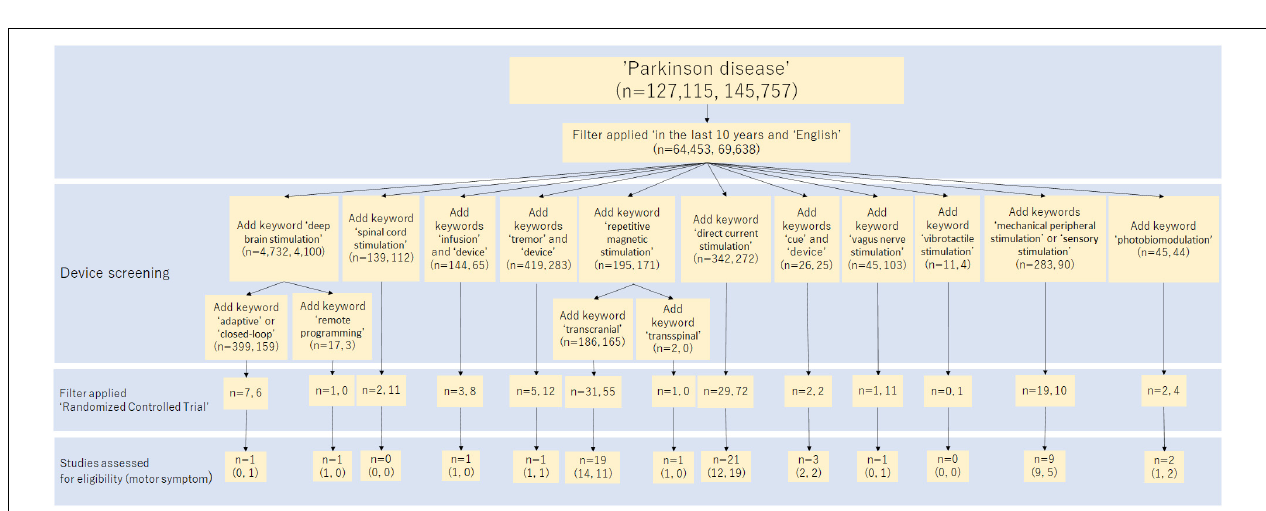
FIGURE 2 | Flow diagram of the study selection process in the systematic review. This diagram shows how to search for studies in a systematic review. The numbers in parentheses show the breakdown of the number of search hits, with PubMed and Scopus listed in that